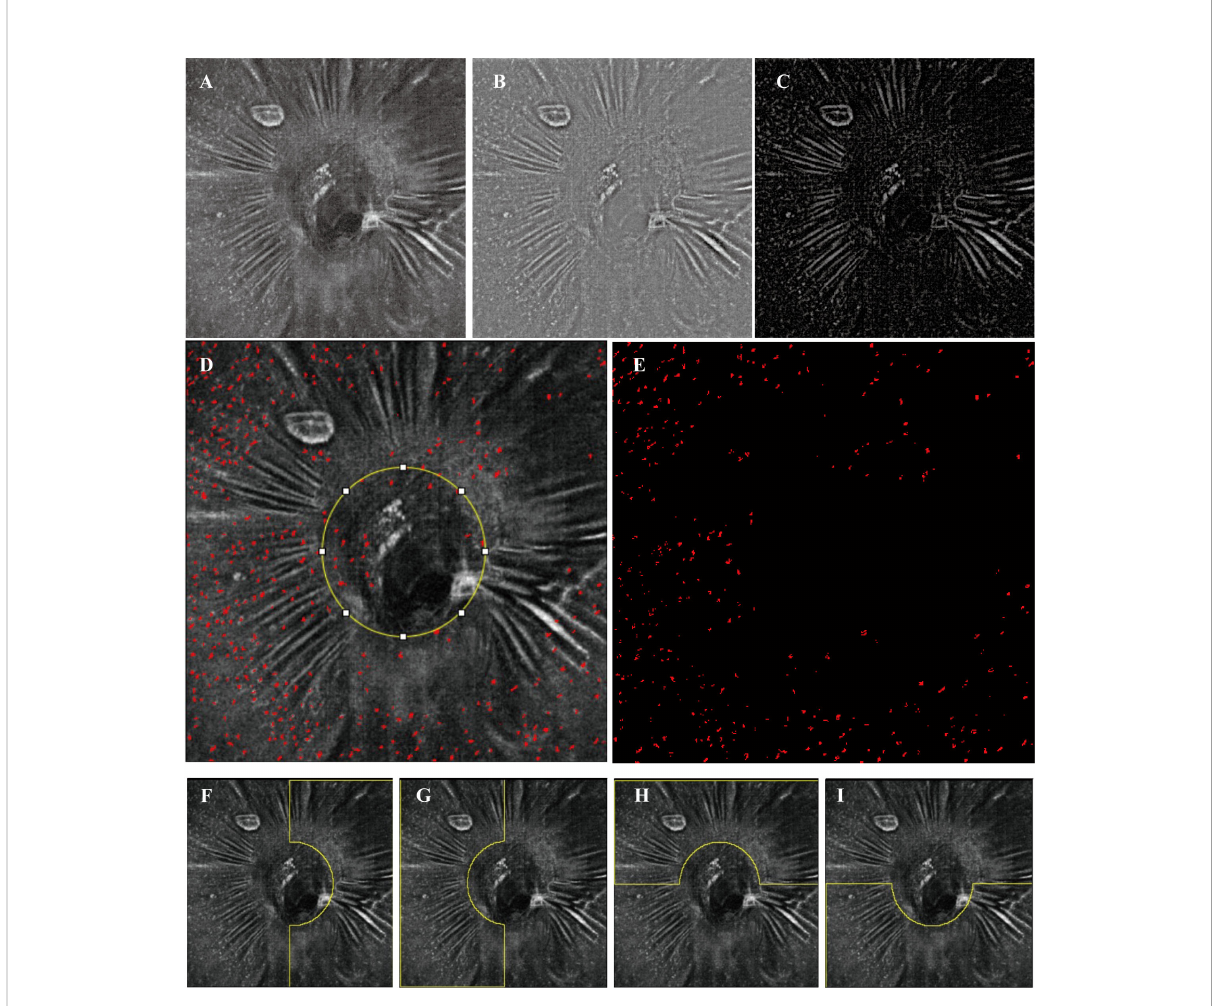
FIGURE 1 Examples of image processing and division of subregions. (A) Registered and averaged en face OCT slab of MLCs. (B, C) Background-subtracted slab and MLC signal from (B) was compensated by the blurred MLC layer OCT and RNFL layer (not shown). (D) Merged image of the MLC (red spots) extracted image and (A) . The yellow circle in (D) outlines the optic disc. (E) The fi nal image for quantitation of MLCs. MLCs in the yellow circle in (D) are excluded. (F – I) Examples (the left affected eye from an acute NAION patient) of the manually divided regions of temporal, nasal, superior and